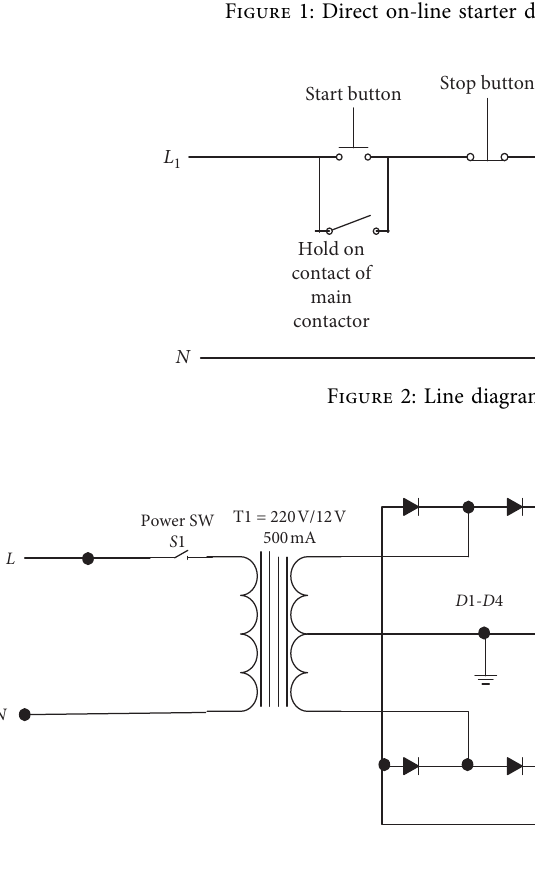
Figure 3: The circuit diagram of the power